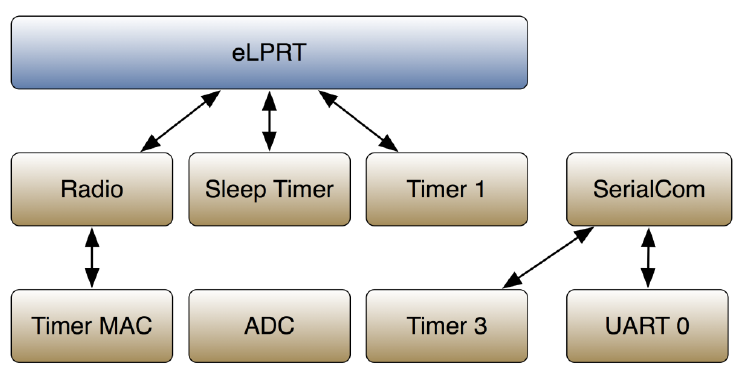
Figure 12. System software